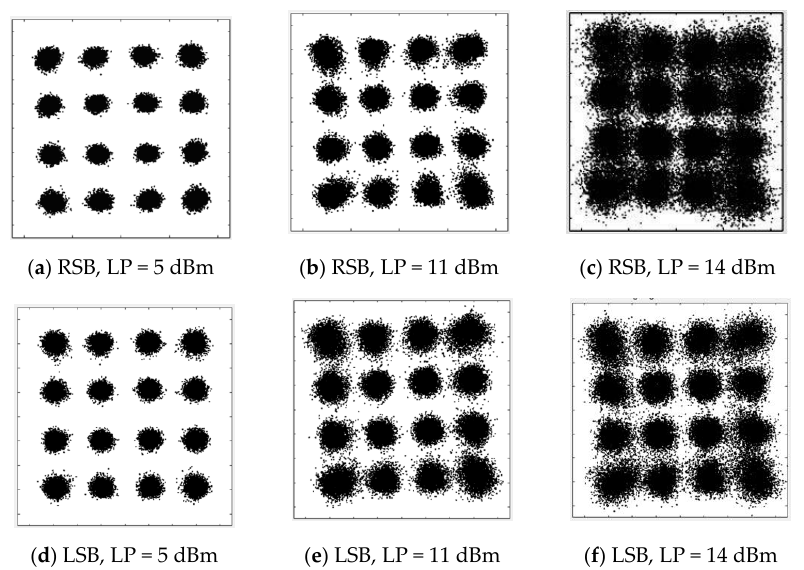
Figure 6. Constellation of 10 Gbaud QAM16 after 80 km SSMF transmission. ( a ) RSB, LP = 5 dBm; ( b ) RSB, LP = 11 dBm; ( c ) RSB, LP = 14 dBm; ( d ) LSB, LP = 5 dBm; ( e ) LSB, LP = 11 dBm; ( f ) LSB, LP = 14 dBm.